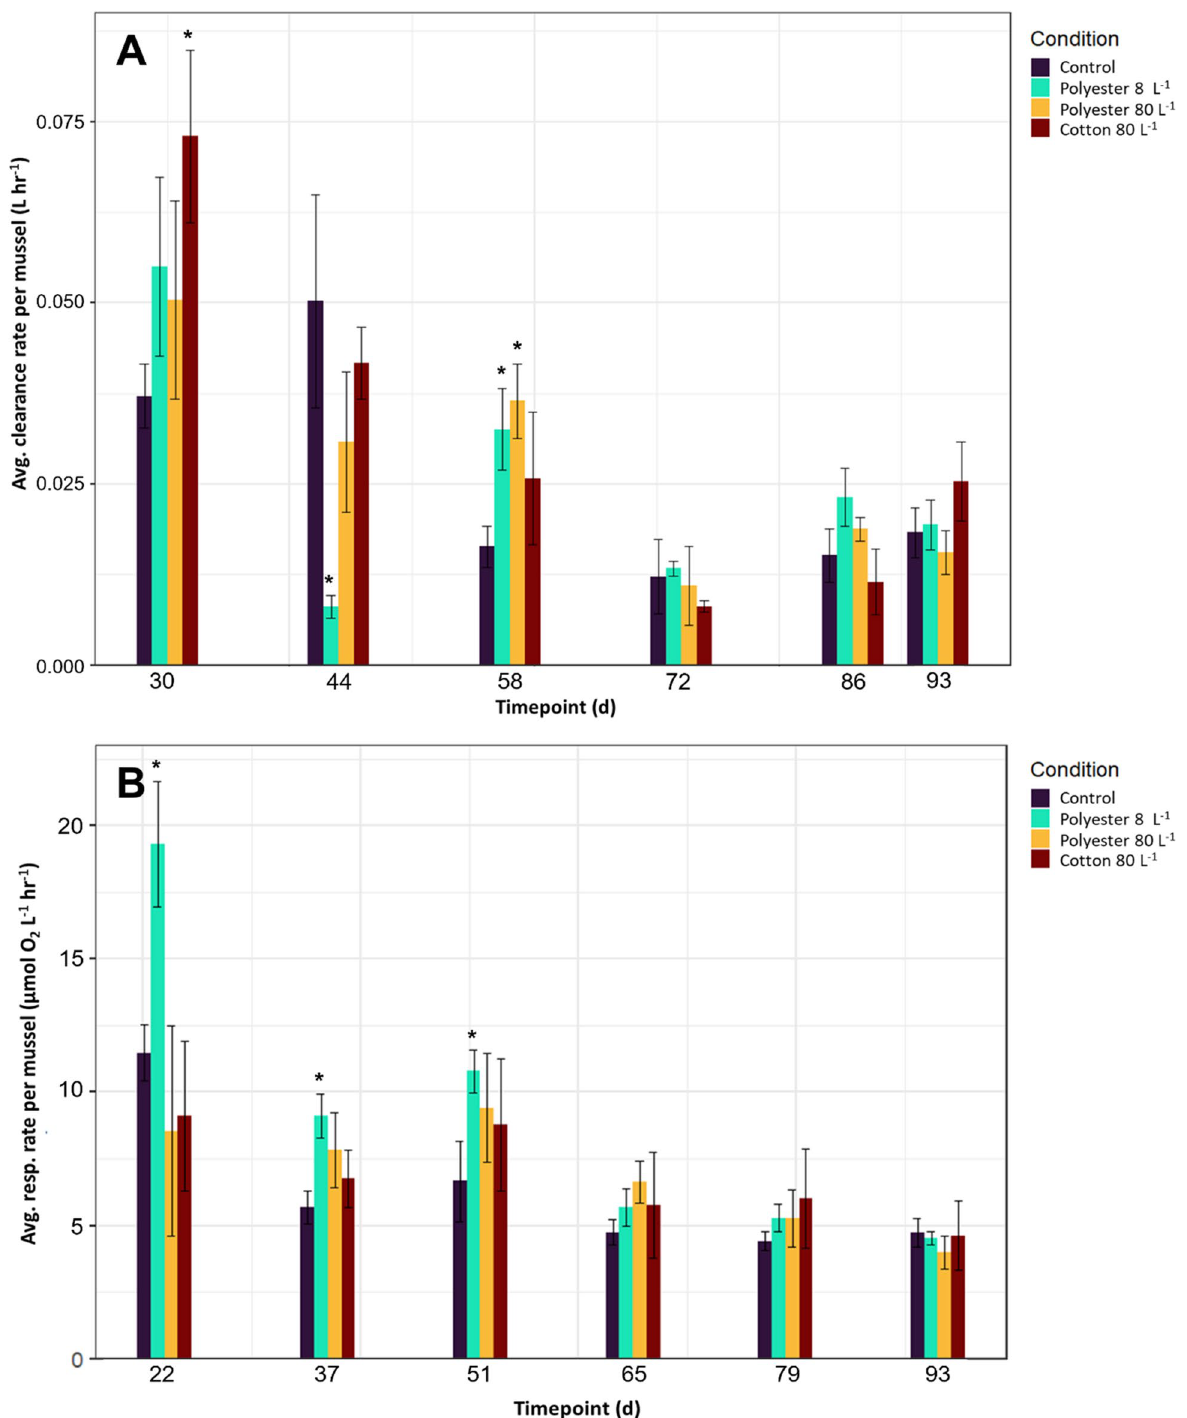
Fig. 2 A Average clearance rate per mussel (L h − 1 mussel − 1 ) for each experimental exposure condition. x-axis denotes days after experiment start. B Average respiration rate per mussel (µmol O 2 L − 1 h. − 1 ) for each experimental exposure condition. x-axis denotes days after experiment start. * denotes statistical significance when compared to the control group at each timepoint, P < 0.05 (Kruskal–Wallis test with Dunn’s post-hoc